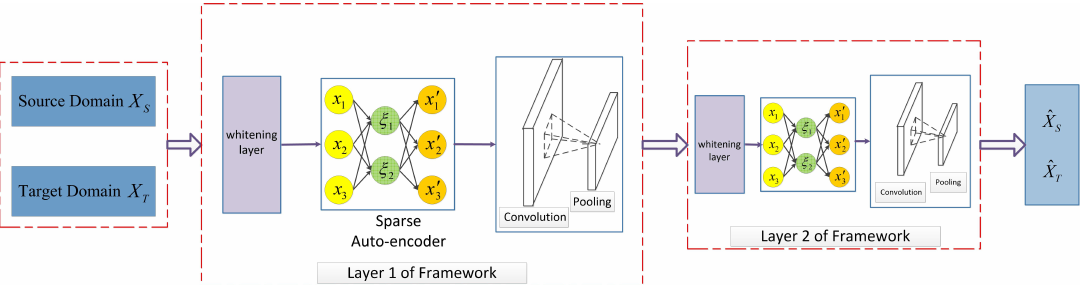
Figure 1. Illustration of our proposed SCSA. Each layer is composed of two main components: a stacked sparse autoencoder and the convolution and pooling kernels. The whitening layer is first introduced for recognition feature